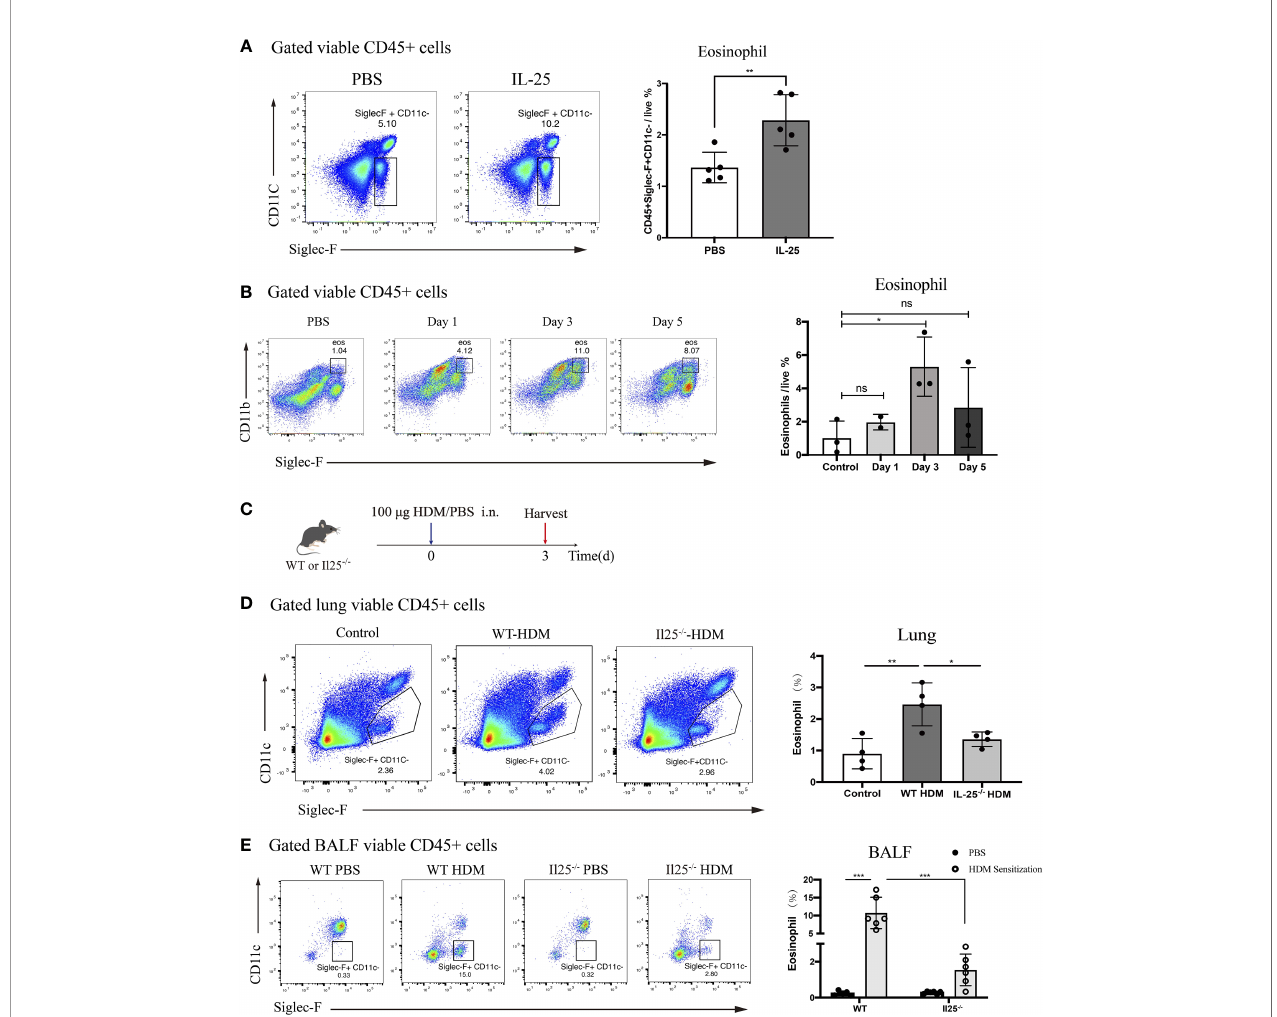
FIGURE 4 | IL-25 induces eosinophils recruitment after HDM sensitization in vivo . (A) Mice were instilled intranasally with 100 ug/40 m L murine recombinant IL-25 or 40 m L PBS. After 1 day, mice were sacri fi ced for analyzing lung eosinophils. Flow plots (left) show the extent of eosinophils (viable CD45 + SiglecF + CD11c - ) in fi ltration into the lungs of mice after IL-25 exposure. The bar graph (right) shows the percentages of eosinophils in fi ltration after IL-25 exposure. Each dot represents a mouse. (B) Flow cytometry analysis of eosinophils in fi ltration into lungs after 100 m g/40 m L HDM or 40 m L PBS sensitization of WT mice at indicated times. (C) Schematic representation of mice 3 days after HDM priming. (D, E) Analysis of the percentages of eosinophils in fi ltration into lungs (D) and airways (E) of WT and Il25 -/- mice 3 days after HDM or PBS sensitization as in (C) . n=5 for (A) ; n=2 ∼ 3 for (B) ; n = 4 for (D) ; n = 6 for (E) Unpaired Student's test for (A, B, D) ; one-way ANOVA for (E) ; ns, no signi fi cant difference, *p < 0.05, **p < 0.01, ***p <